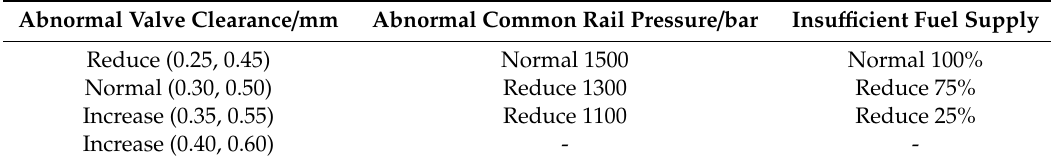
Table 4. Simulated faults details.